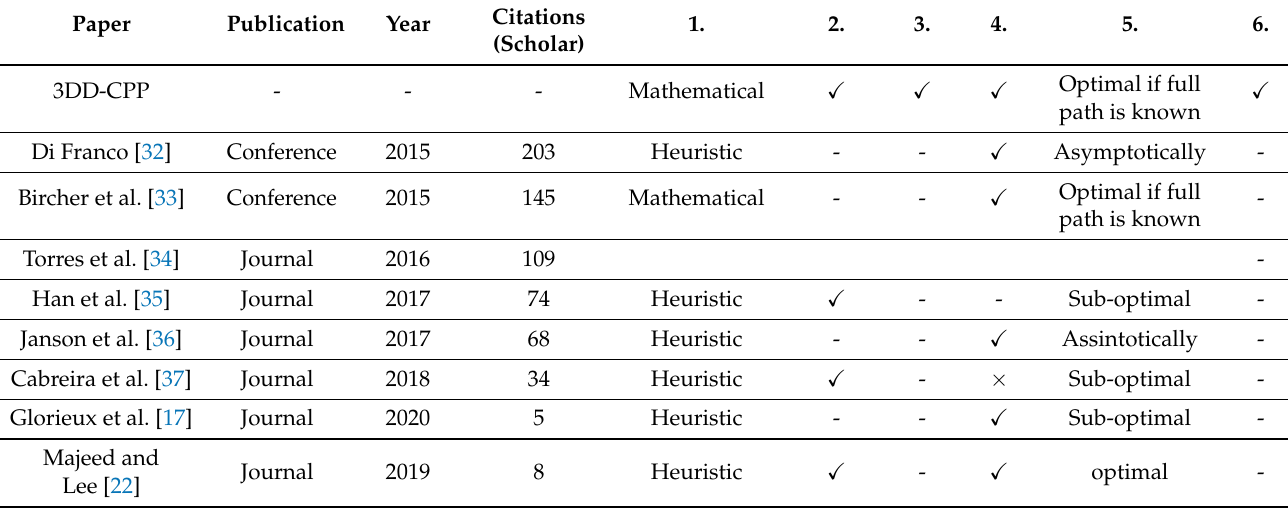
Table 1. Literature background